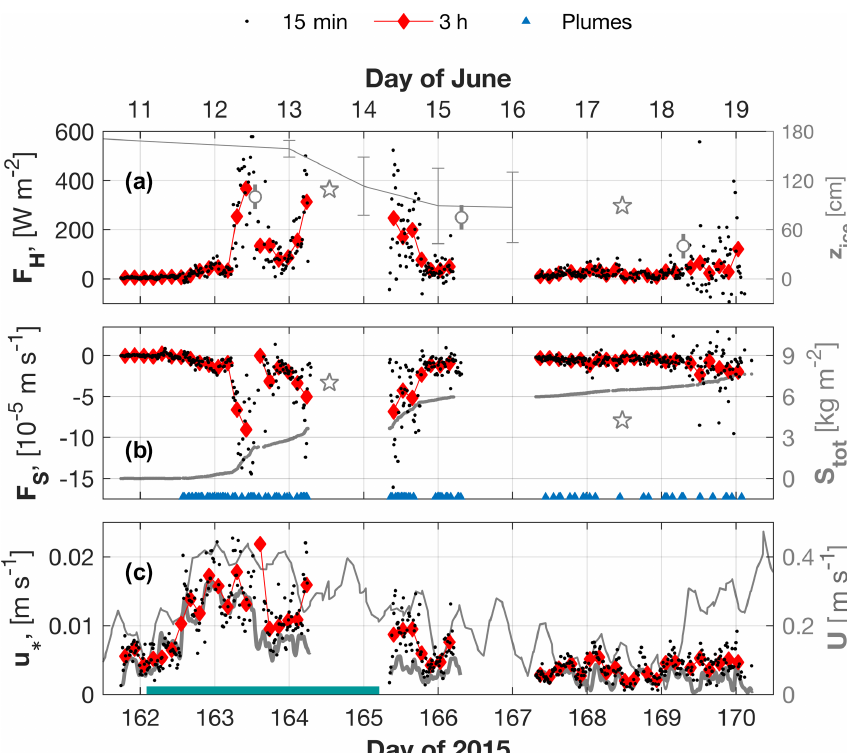
Figure 2. Turbulent fluxes of (a) heat and (b) salt and (c) friction velocity are shown as 15min data points (dots) and 3h bin averages (diamonds). In (a) , sea ice thickness is shown from manual measurements in the TIC hole (circles), hot wires (line), and two ice cores (stars). (b) Total salt content of the ice cores (stars) and measured cumulative salt flux, S tot , is given in kgm − 2 (gray). Identified plumes are indicated by blue triangles. In (c) , the sea ice drift speed (thin) and along-stream current (TIC, thick) are shown (gray), and the timing of a passing storm is indicated by the green line (defined by Cohen et al.,